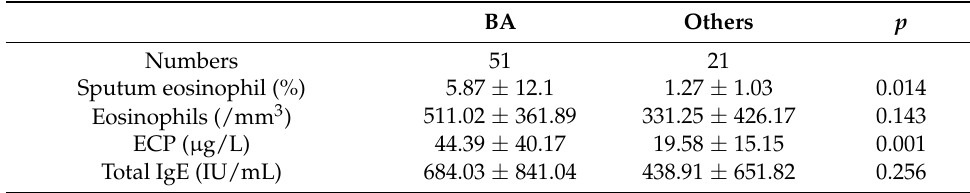
Table 2. Laboratory results of each